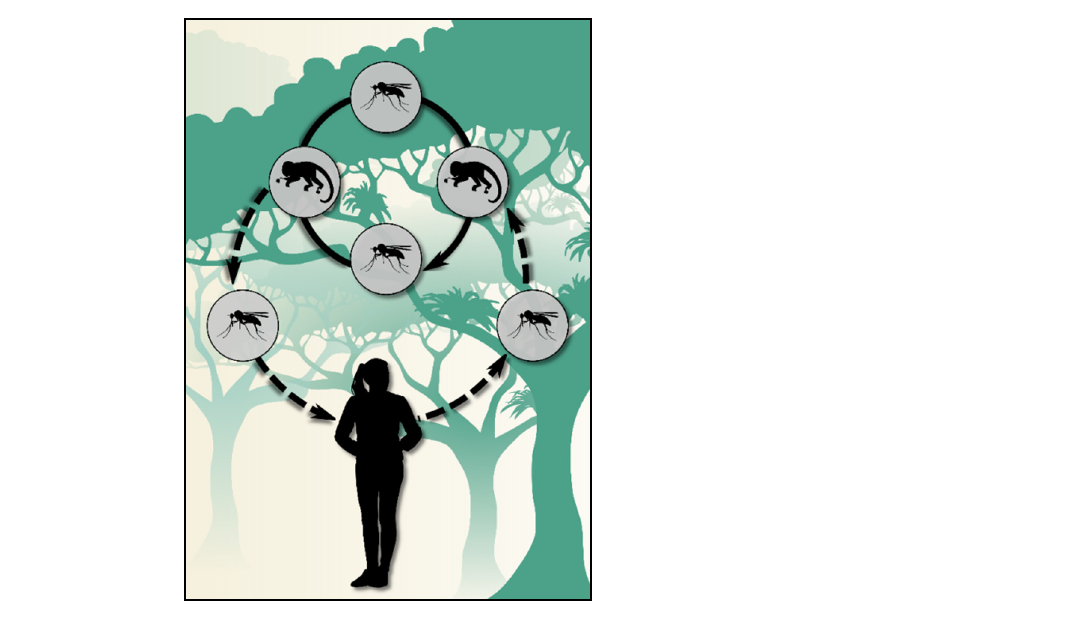
Figure 2. Scheme of the transmission cycle of bromeliad-malaria that is hypothesized at the Atlantic Forest biome.